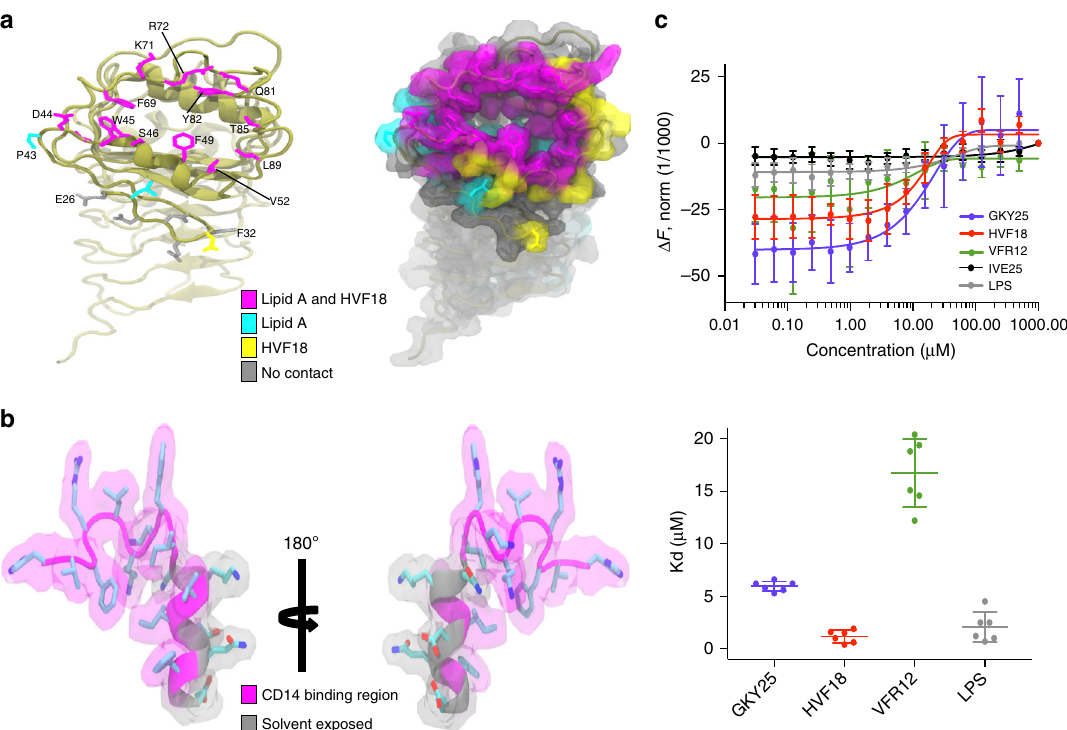
Fig. 6 Thrombin C-terminal peptides interaction and binding to human CD14 ligand binding pocket. a Ribbon representation of CD14 N-terminal hydrophobic pocket rim highlighting side-chains of residues contacting LPS (cyan), HVF18 (yellow), and both LPS and HVF18 (magenta) in an all-atom molecular dynamics simulation model. b Ribbon representation of HVF18 indicating residues in contact with CD14 hydrophobic pocket (magenta) and solvent exposed (grey). c Microscale thermophoresis assay quantifying CD14 interaction with TCPs and LPS. The peptide IVE25 was used as negative control. MST analysis was performed in concentration range 1000 – 0.03 μ M of HVF18, GKY25, IVE25 and 500 – 0.03 μ M of LPS. K d constants of HVF18